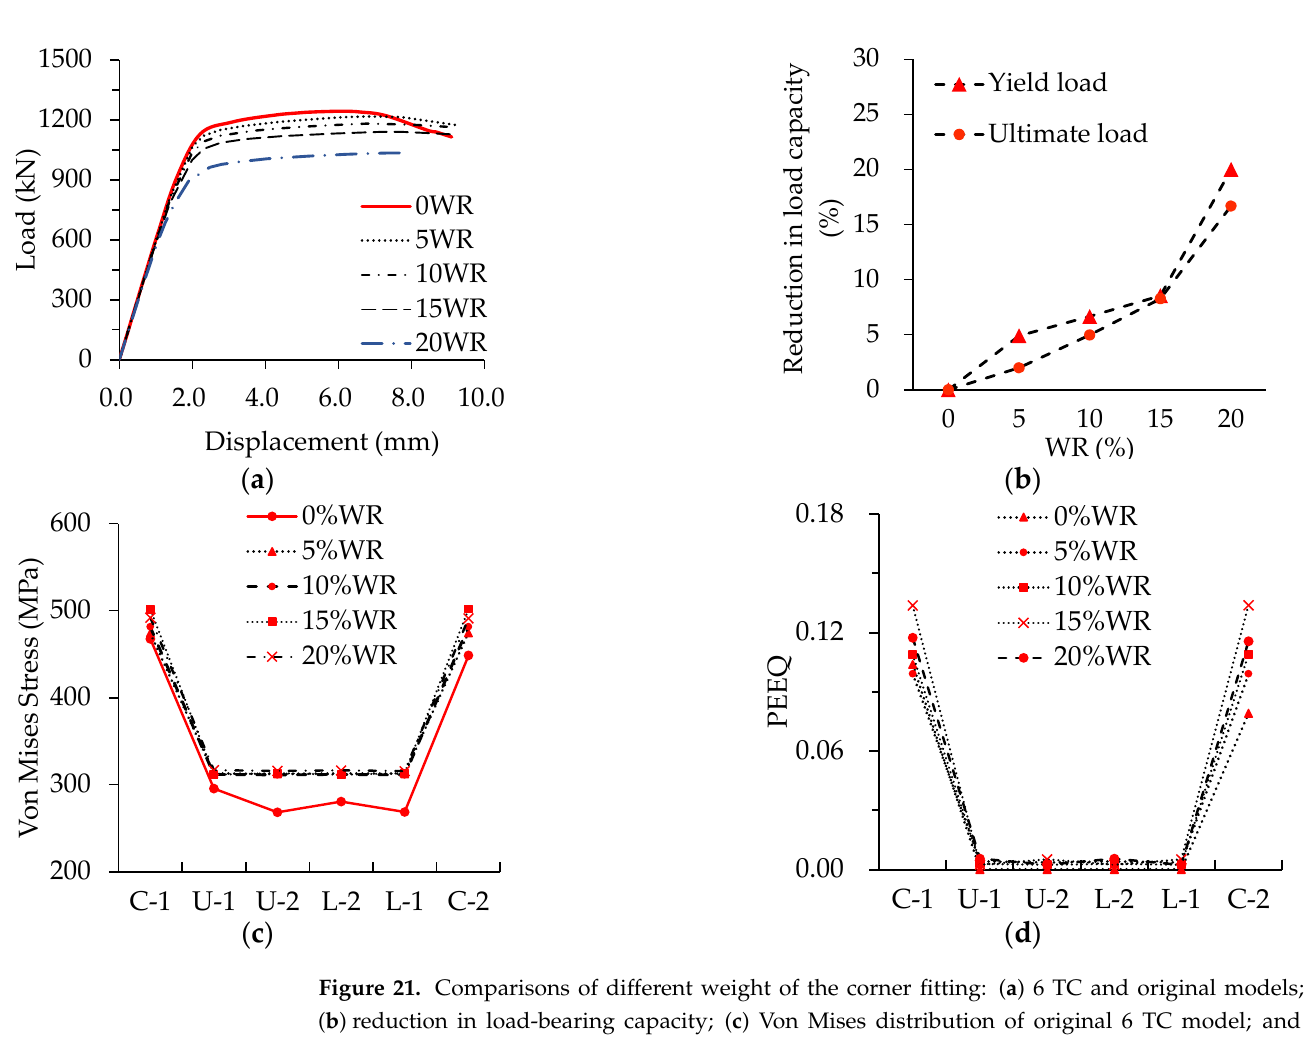
Figure 20. Comparisons of different column locations: ( a ) 6 TC models with 0% weight reduction; ( b ) Von Mises distribution of 6 TC with 0% WR model; ( c ) PEEQ distribution of 6 TC with 0% WR model; ( d ) Von Mises distribution of 8 TC with 0% WR model; ( e ) PEEQ distribution of 8 TC with 0% WR model; ( f ) Von Mises distribution of 10 TC with 0% WR model; and ( g ) PEEQ distribution of 10 TC with 0% WR model.